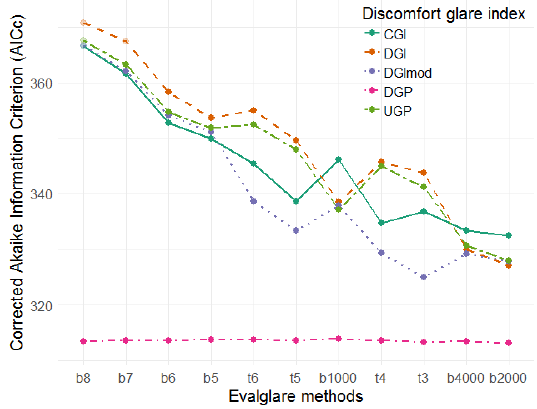
Figure 9. Comparison of AICc for each discomfort glare index between the studied evalglare methods (laboratory study).